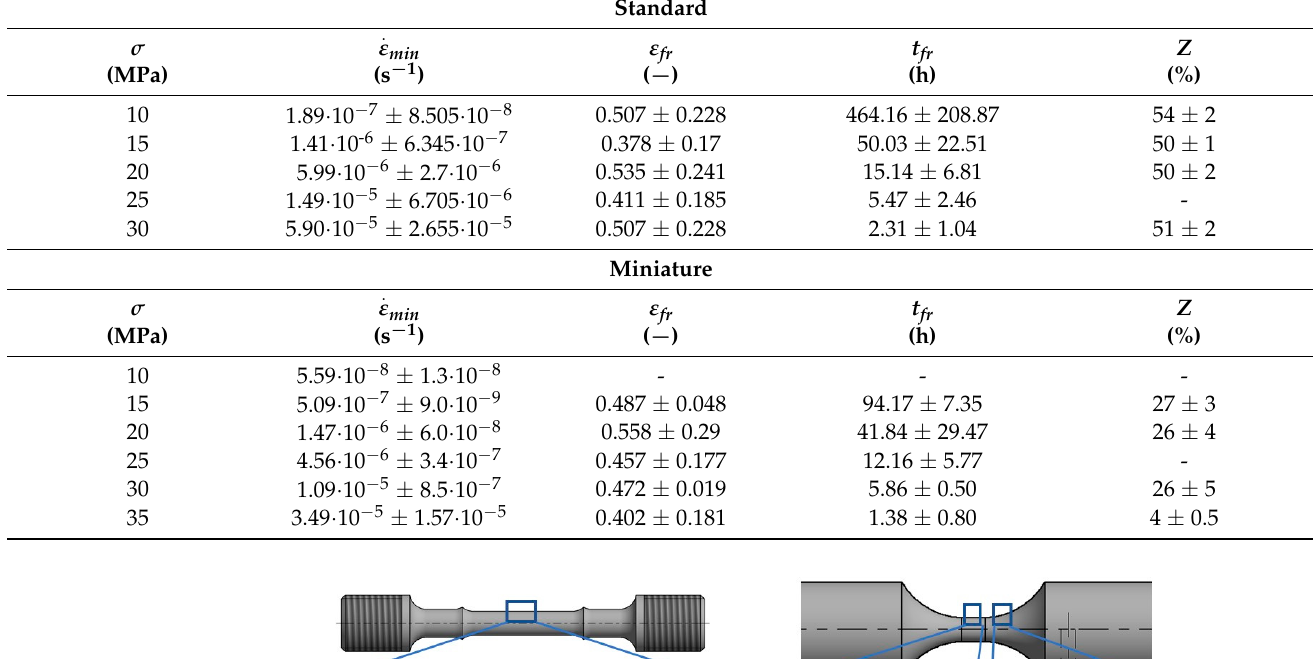
Table 4. Creep parameters of all investigated samples.